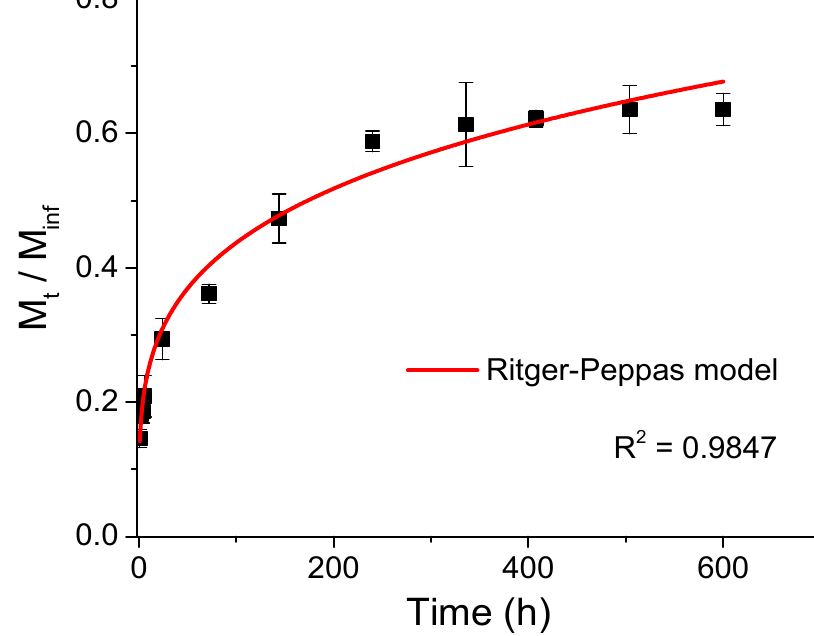
Figure 2. Cellulase release profile from chitosan–caseinate nanoparticles in phosphate-buffered saline solution PBS (pH 7.4) at a temperature of 3 7 °C. Ritger–Peppas model fitting curve in the time ranges up to 600 h (25 days).